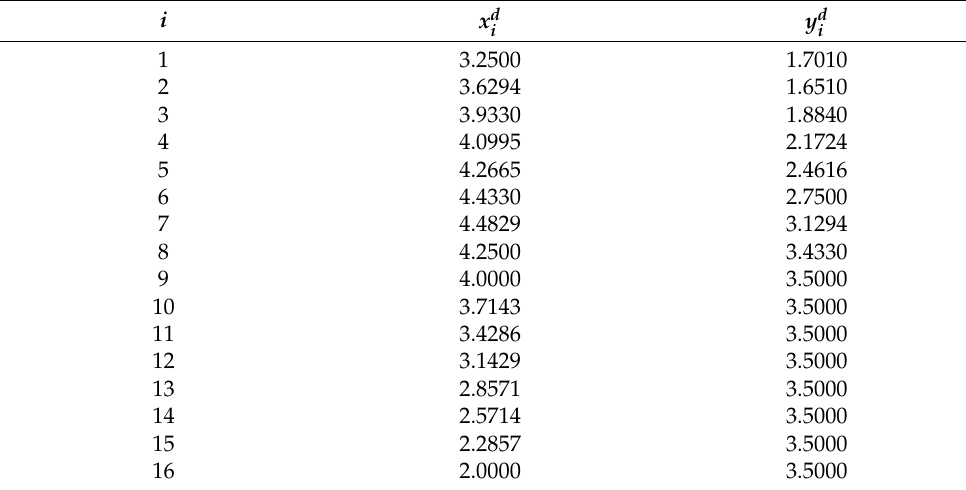
Table 1. Example 1. Initial data.